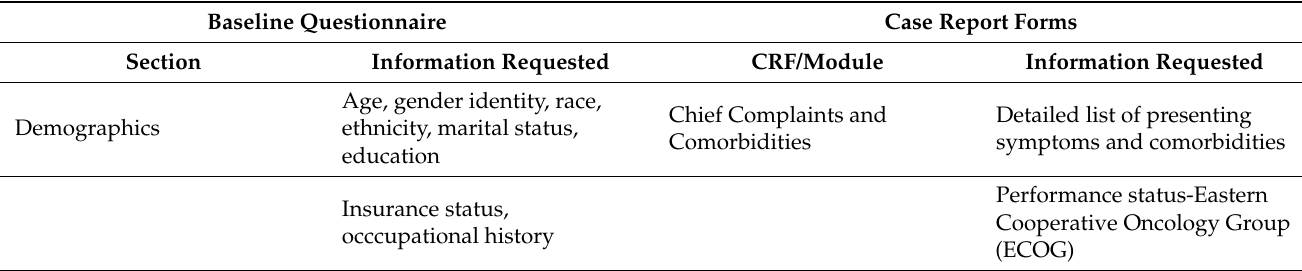
Table 2. Data elements solicited in the Florida Pancreas Collaborative Baseline Study Questionnaire or Case Report Forms